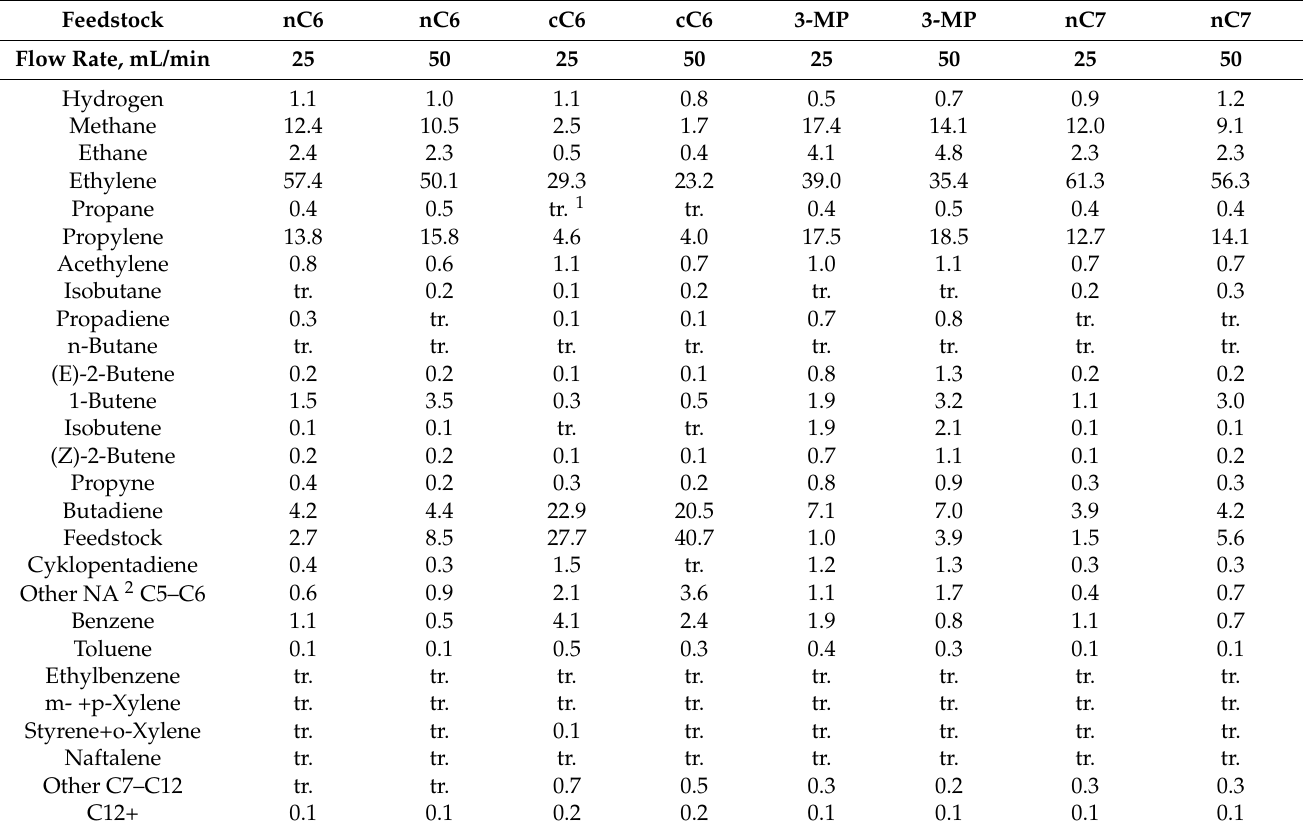
Table 2. Pyrolysis of pure co-pyrolysis partners at 820 ◦ C and carrier gas flow rate of 25 mL/min and 50 mL/min. Composition ( w / w ) of reaction mixture after pyrolysis (in columns: hexane; cyclohexane;